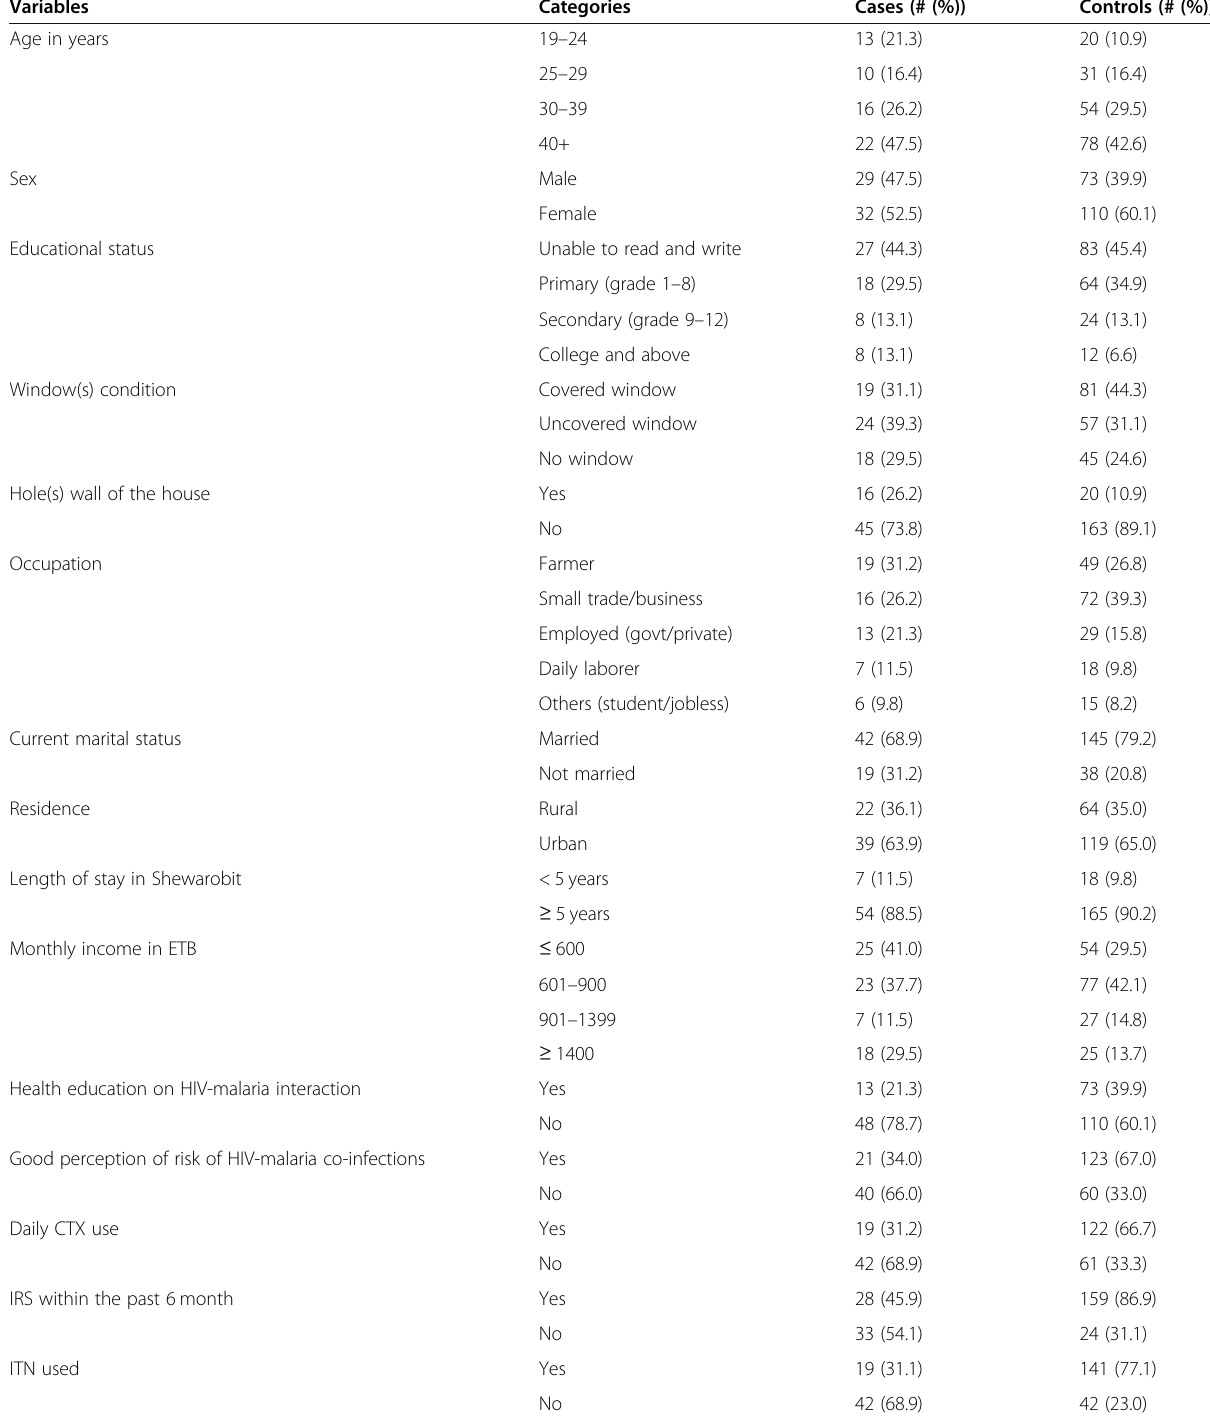
Table 1 Socio-demographic characteristics of PLWHIV in Shewarobit Health Center, Shewarobit district, Amhara Region,